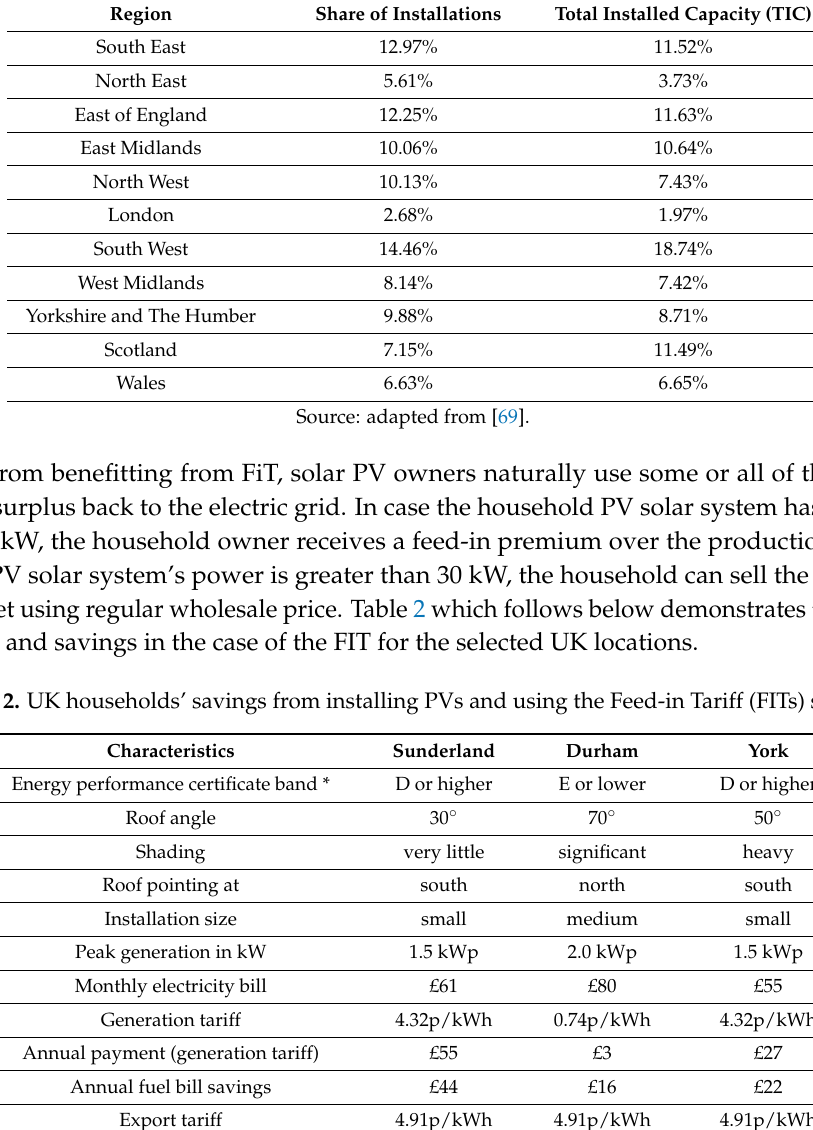
Table 1. Share of installations and total installed capacity: a case of the United Kingdom.